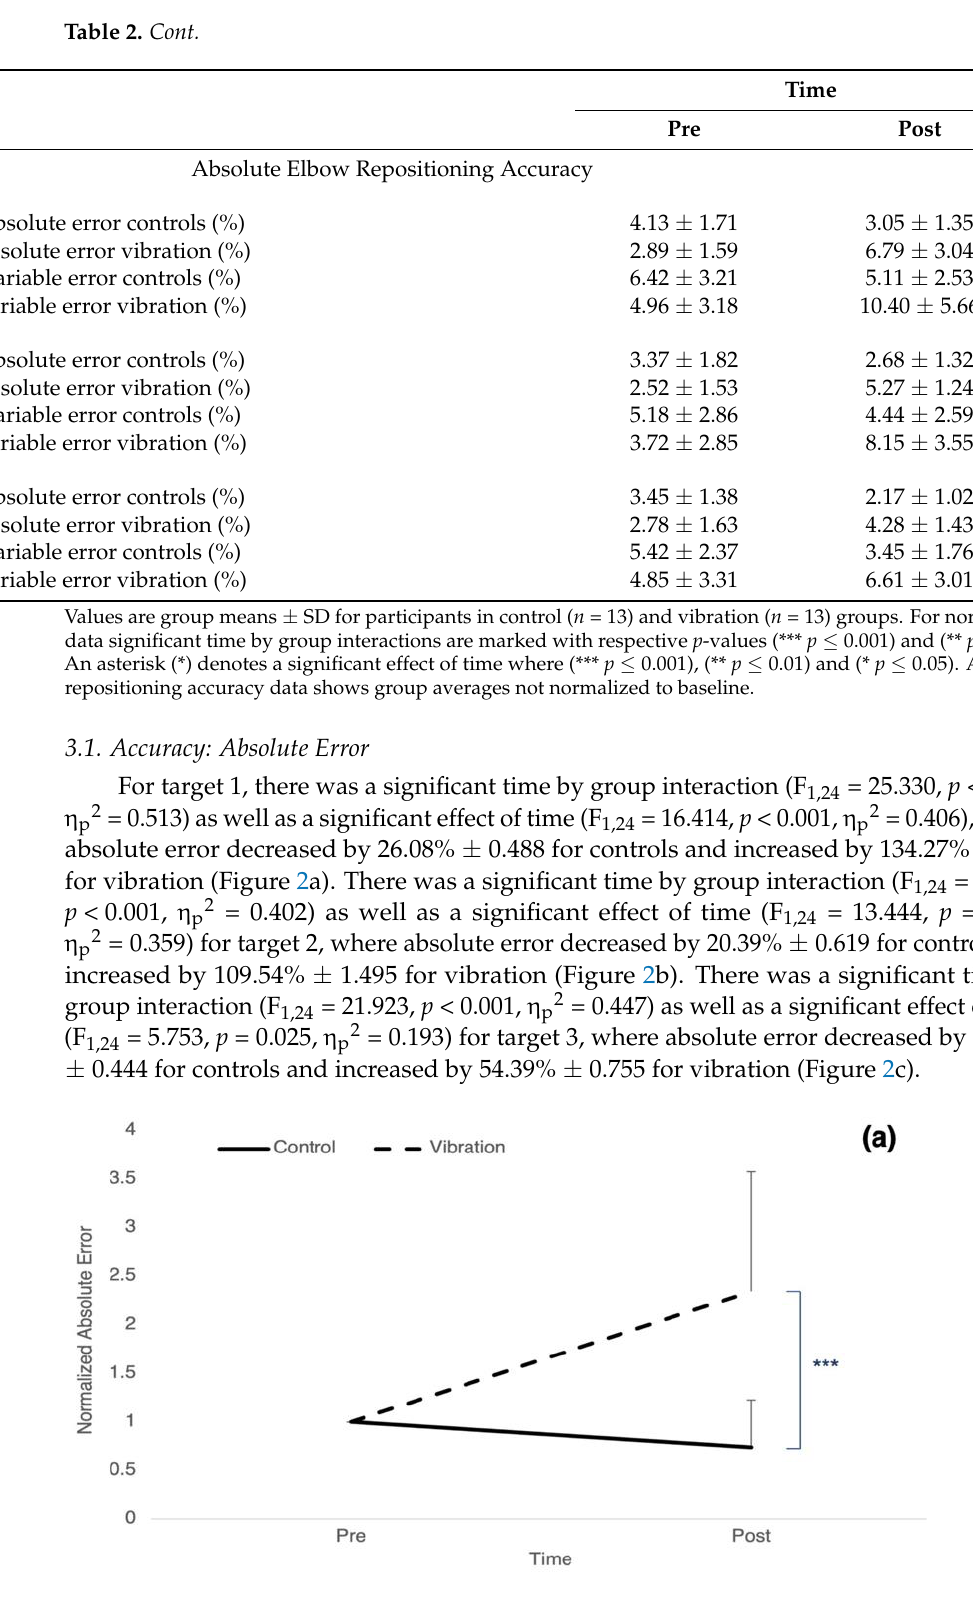
Figure 2. Normalized mean absolute error for controls (solid line) and vibration group (dashed line). Post measures have been normalized to baseline scores. ( a ) target angle 1 between 80 – 90 degrees. ( b ) target angle 2 between 90 – 100 degrees. ( c ) target angle 3 between 100 – 110 degrees. Error bars represent SD. (*** p ≤ 0.001). 3.2. Precision: Variable Error Target 1 had a significant time by group interaction (F 1,24 = 10.510, p = 0.003, η p2 = 0.305) as well as a significant effect of time (F 1,24 = 7.917, p = 0.01, η p2 = 0.248) where variable error decreased by 20.43% ± 0.49 in controls and increased by 109.55% ± 1.80 in the vibra- tion group (Figure 3a). For target 2, there was a significant time by group interaction (F 1,24 = 9.280, p = 0.006, η p2 = 0.279) as well as a significant effect of time (F 1,24 = 10.443, p = 0.004, η p2 = 0.303), where variable error decreased by 14.22% ± 1.06 in controls and increased by 119% ± 3.14 in the vibration group (Figure 3b). There was a significant time by group in- teraction (F 1,24 = 12.226, p = 0.002, η p2 = 0.337) for target 3, where variable error decreased